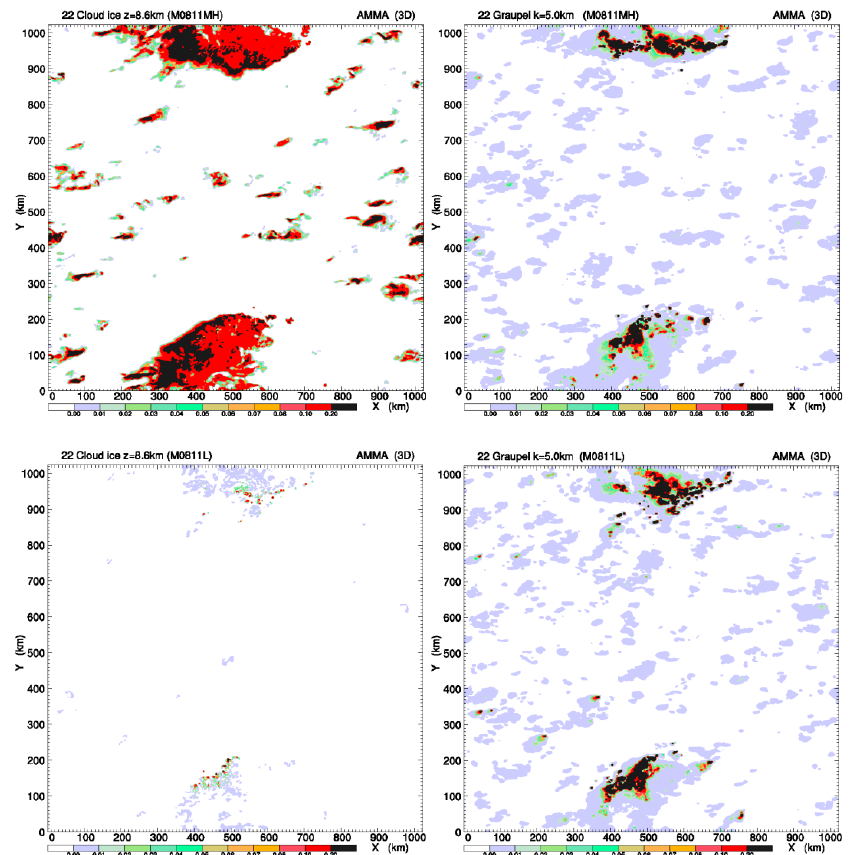
Figure 9. Horizontal distribution of the cloud–ice mixing ratio at 8.6 km ( left ; representing cloud anvil) and the graupel mixing ratio at 5 km ( right ; representing convective cores) at 0400 UTC 11 August 2006. The results come from the two numerical experiments with a ( top ) high and ( bottom ) low number concentration of activated IN. The broad anvil in the experiment with the plentiful activated IN (top/left) agrees with the in-situ satellite and radar observations during the field campaign of the AMMA (the African Monsoon Multidisciplinary Analysis) over West Africa. Adapted with permission from Zeng et al. (2013) [43].